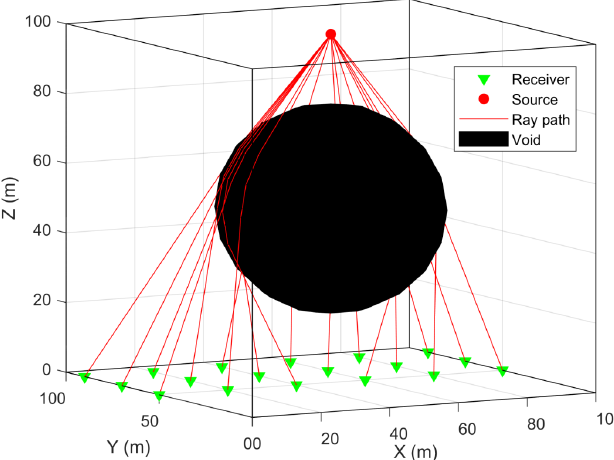
Figure 8. In the case of a single void, the ray path is calculated by the proposed method.